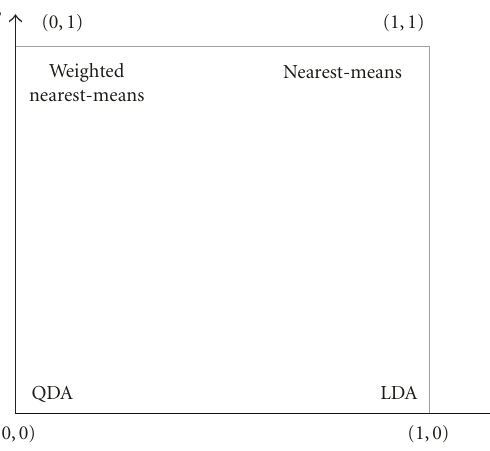
Figure 4: RDA model selection. ( λ = 0, γ = 0) represents QDA, ( λ = 1, γ = 0) represents LDA, ( λ = 1, γ = 1) corresponds to the nearest-means classifier, and ( λ = 0, γ = 1) represents a weighted nearest-means